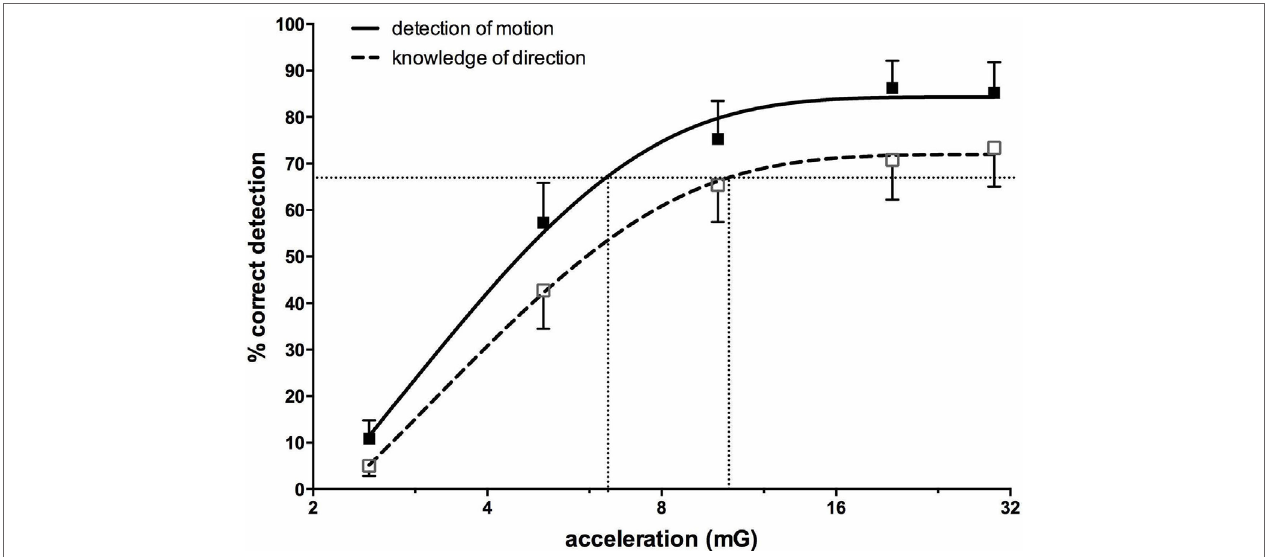
FiGURe 8 | Percentage correct (mean ± SE) detection of motion, and correct detection of the direction of motion, for 16 subjects exposed to sinusoidal linear acceleration at a constant rate of 0.2 Hz but at accelerations ranging from 1.25 to 30 mG. Semi-logarithmic plot of data from 2.5 to 30 mG, with fitted sigmoidal curves shown superimposed. Reproduced with permission from Hammam et al.